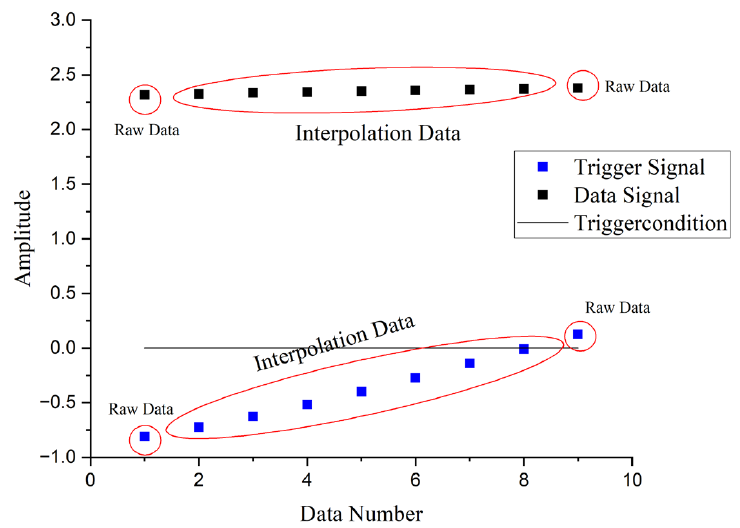
Figure 2. Schematic diagram of the interpolation process.